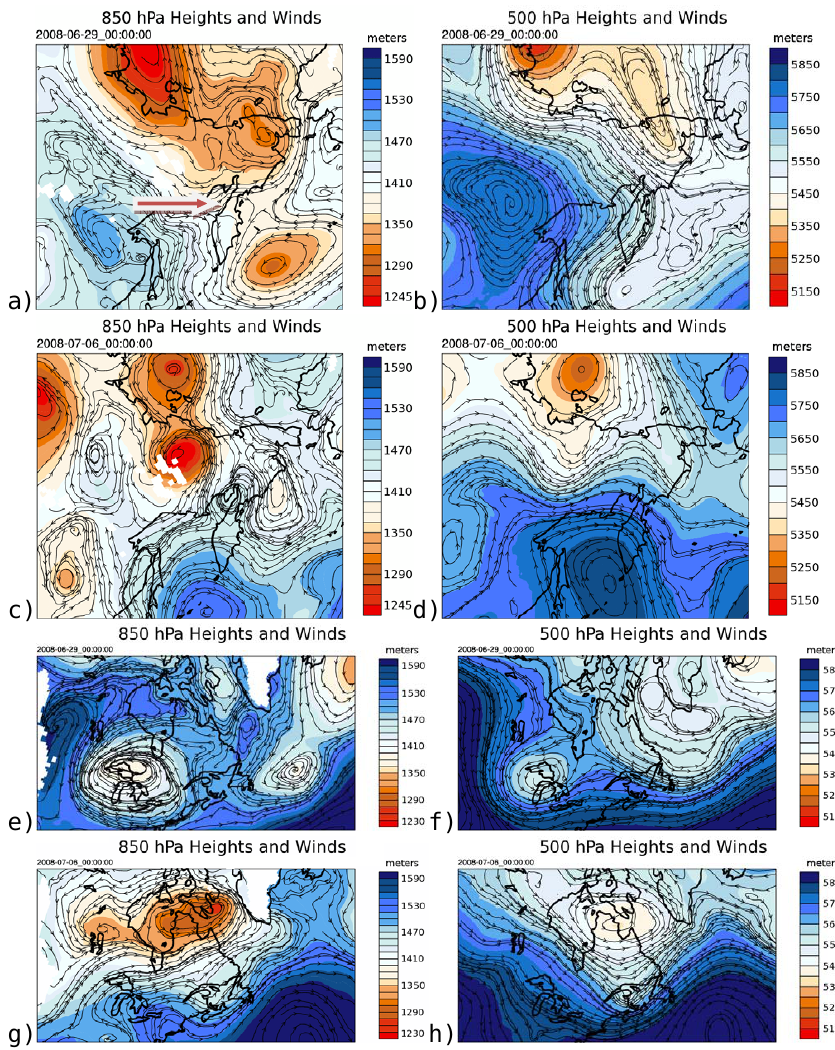
Fig. 7. Geopotential heights (color filled lines) and streamlines over northeastern Asia and the North Pacific Ocean (a-d) and North America (e-h) at 850 hPa (left column) and 500 hPa (right) for 0000 UTC 29 June and 0000 UTC 6 July 2008. The arrow in panel a) denotes the saddle point where the north and south pathways from Russia split. Note that streamlines and trajectories are not equivalent.